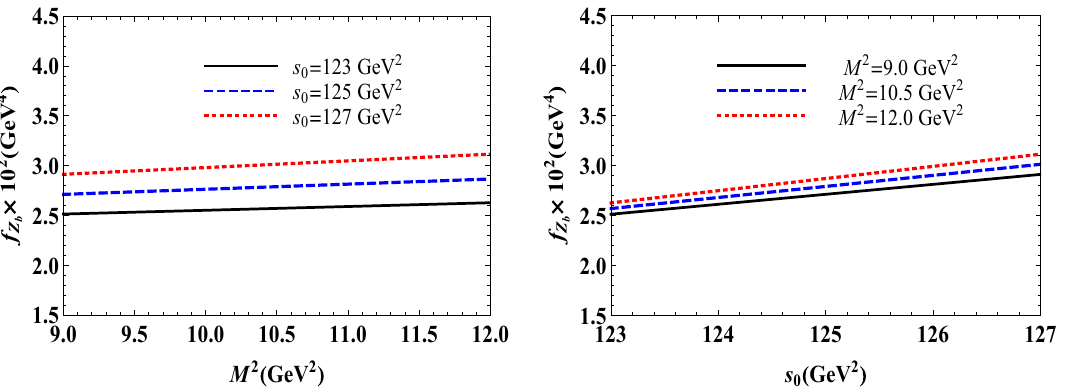
of the Z b resonance on the Borel parameter at chosen values of s 0 (left panel), and on the s 0 b